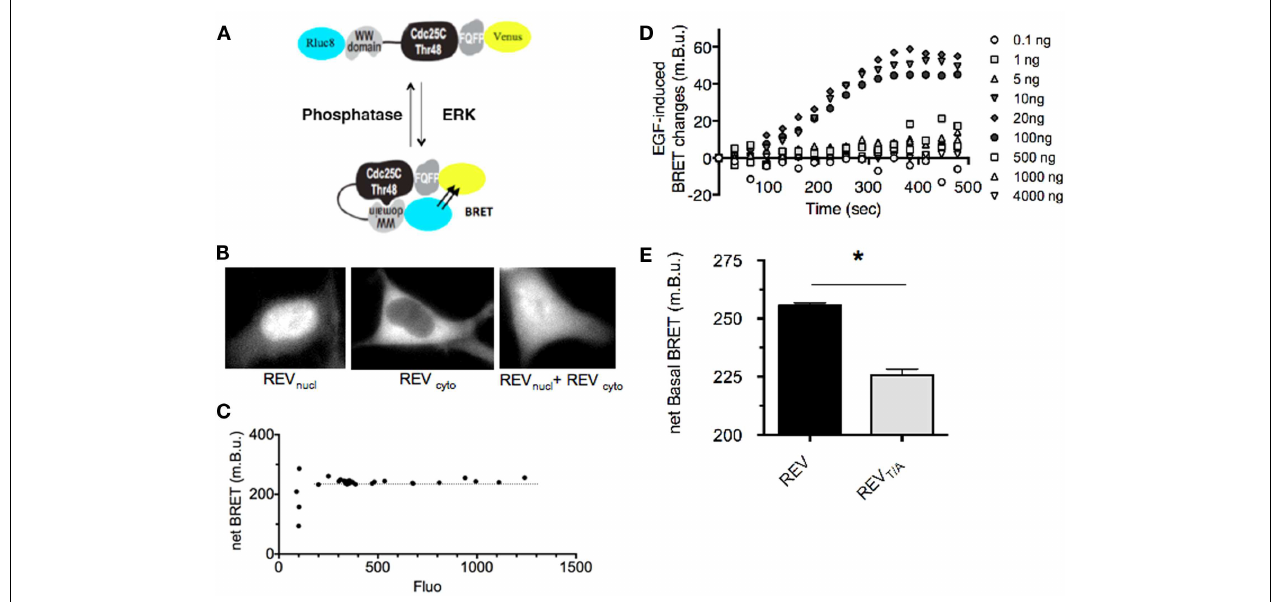
FIGURE 1 | Design and characterization of REV, a BRET-based sensor of ERK activity . (A) Schematic representation of ERK sensor-conformational changes induced upon ERK activation, adapted from Harvey et al. (18).The conformational change induced by REV-phosphorylation increases the proximity between Rluc8 andVenus, promoting BRET-increase. (B) Fluorescence of REV nucl and REV cyto transfected alone or together in HEK293T cells. (C) Determination of the expression level of REV required for a reliable BRET measurement. HEK293T cells were transfected with increasing amounts of pRK5-Rluc8-EKAR Nucl -Venus and pRK5-Rluc8-EKAR cyto -Venus plasmids. BRET in cell population was expressed as a function of REV-fluorescence reporting the expression level of REV. Note that the BRET remained constant for a fluorescence of REV comprised between 200 and 1,300 photon counts which corresponds to cells transfected with 10–4,000ng of plasmid per 100mm diameter culture dish. (D) Determination of the expression level of REV required for efficient report of ERK